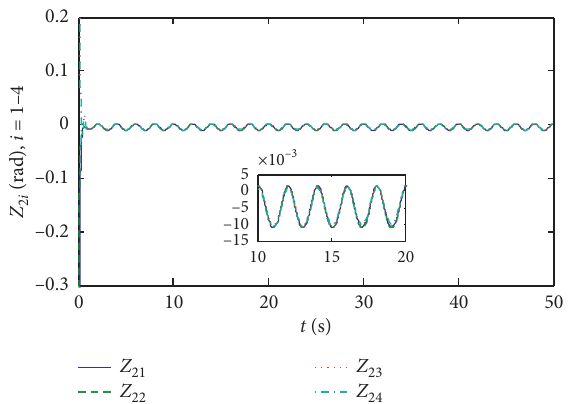
Figure 18: The auxiliary variables Z